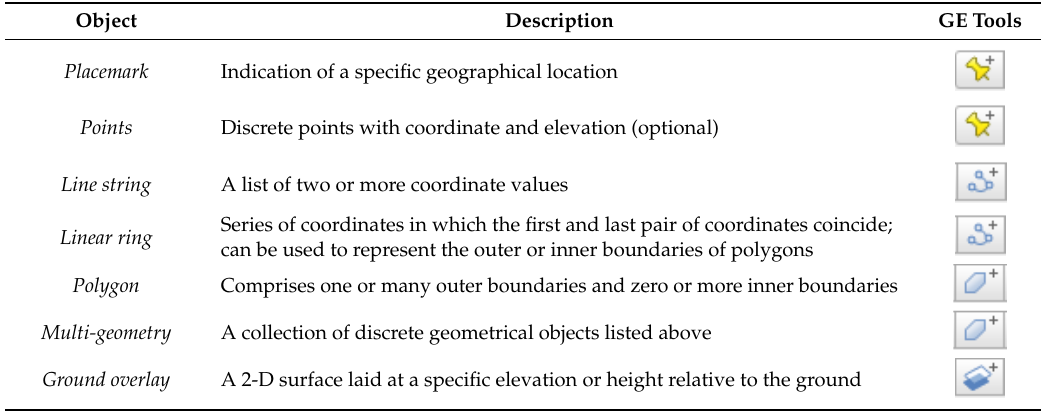
Table 2. KML geometrical object types.